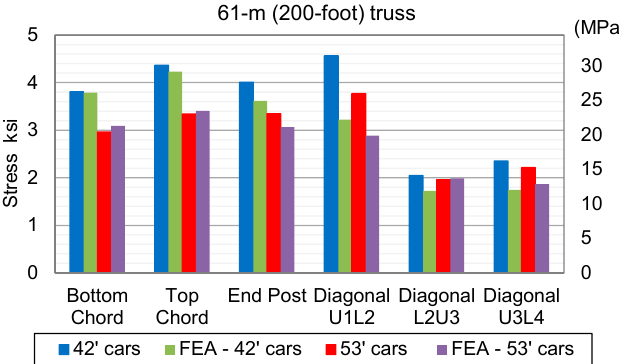
Figure 23. Stress comparison of measured data and FEM results, 61 ‐ m (200 ‐ ft) span.